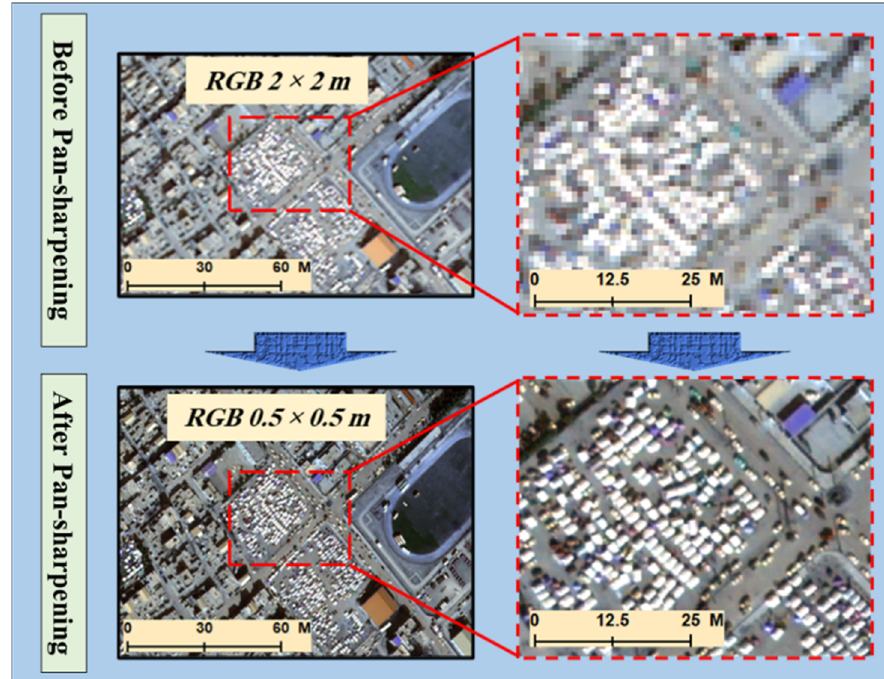
Figure 6. Result of pan-sharpening (top image with a resolution of 2 m and bottom image with a resolution of 0.5 m).